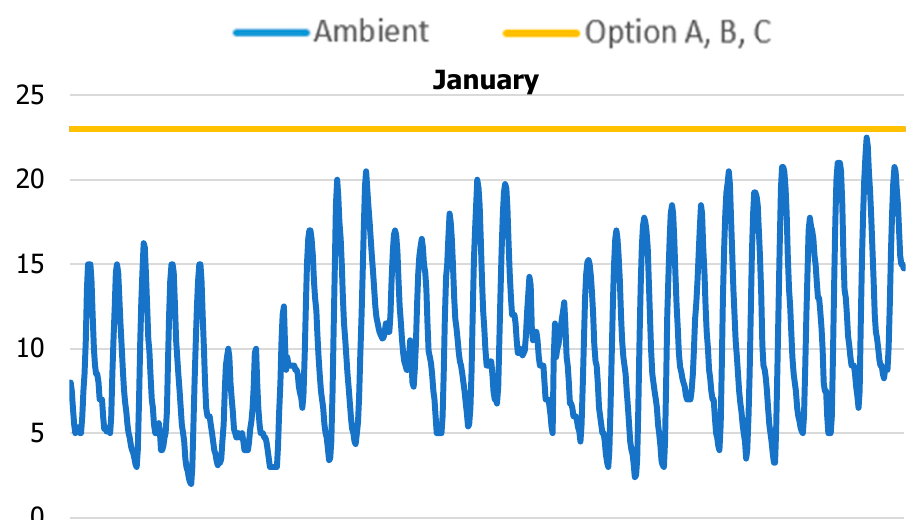
Figure 25. Temperature comparison for the month of June. Note: All the options, A, B and C, have a same set point temperature of 23 °C, so that is why all the lines are merged and displayed as a single yellow line.